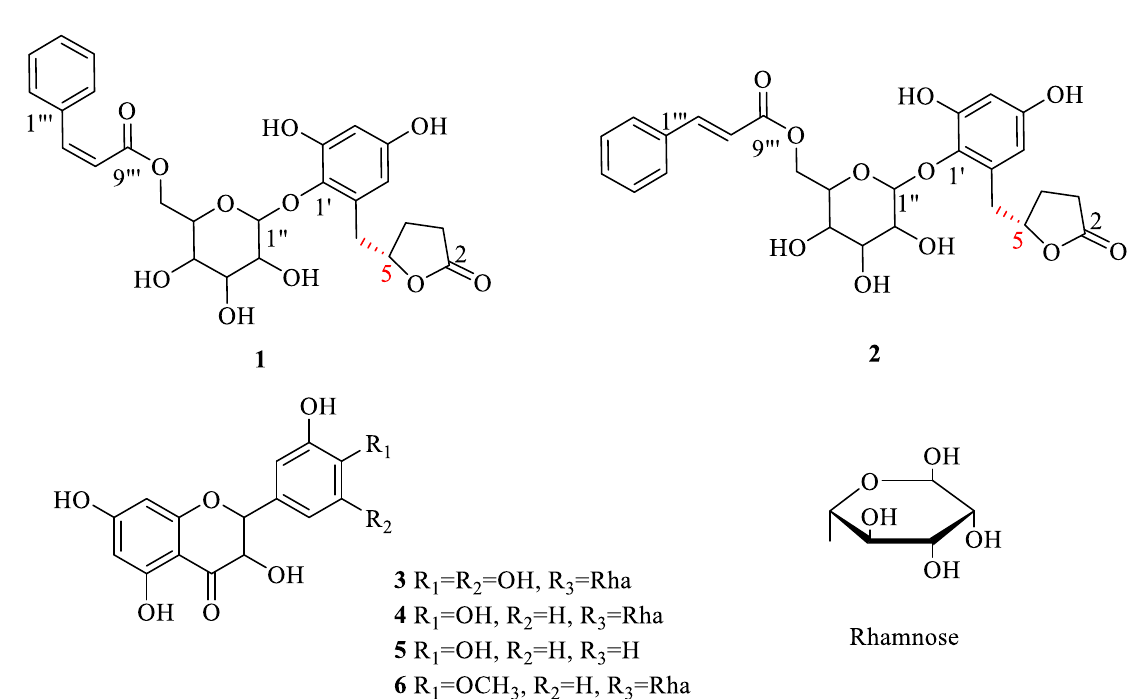
Figure 1 . The key HMBC (H → C) and 1 H- 1 H COSY correlations of compounds 1 – 2.